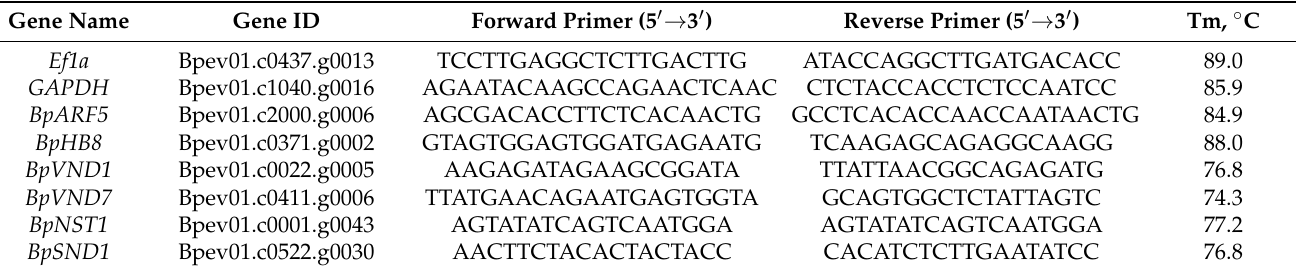
Table 5. List of primers for the RT-PCR